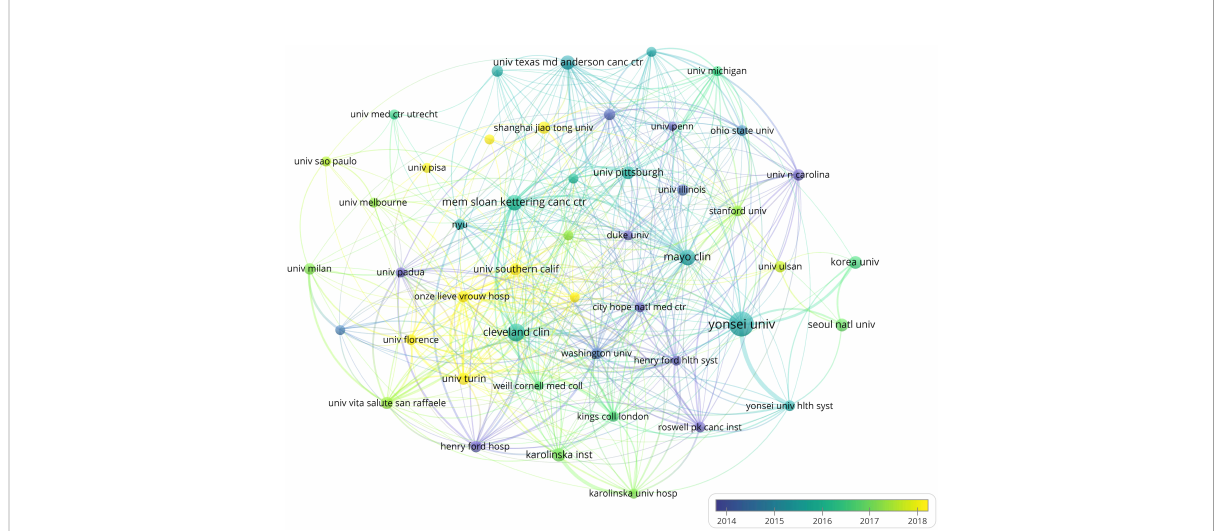
FIGURE 4 Knowledge map of the institutional collaboration network related to robotic surgery in oncology. The size of the nodes is proportional to the number of publications of the institution, and the warmer the color of the nodes, the later the average publication time of the institution. The lines between nodes represent the cooperation relationship between institutions, and the thickness of the lines is positively correlated with the intensity of cooperation. From: